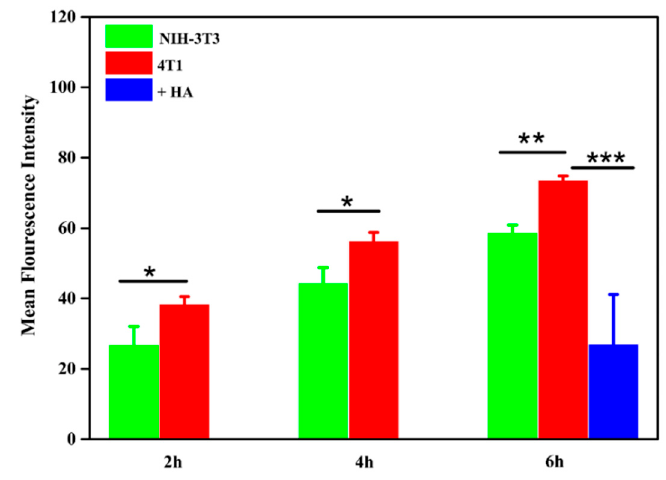
Figure 8. Mean fluorescent intensities of NIH-3T3 and 4T1 cells treated with DOX–CD C-H at different times. Data represent mean ± SD, n = 3; * p < 0.05, ** p < 0.01 and *** p < 0.001, vs. 4T1 cells. The competitive inhibition experiment was performed by treating 4T1 cells with free HA (10 mg/mL) before adding DOX–CD C-H complexes.